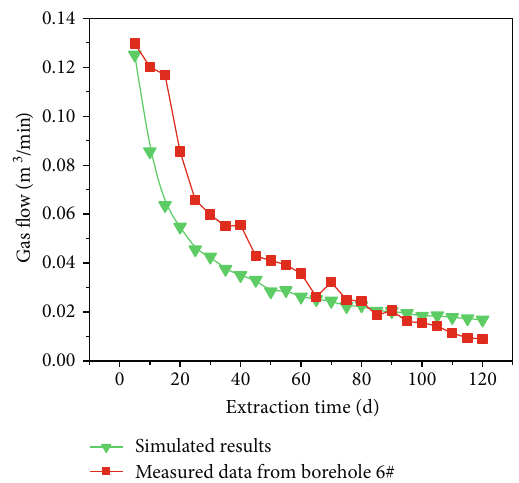
Figure 3: Comparison between simulated and measured gas fl